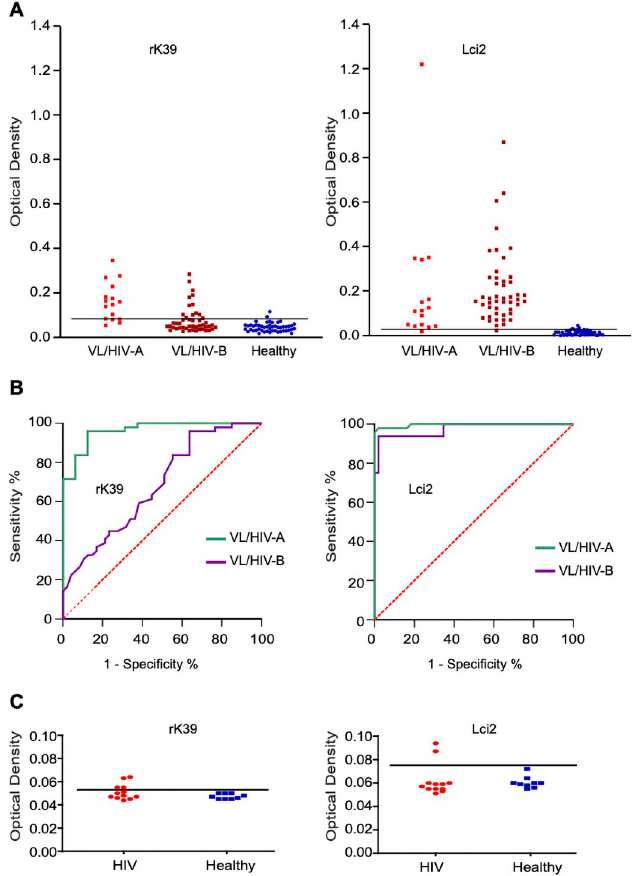
Fig 2. Serological evaluation of rK39 and Lci2 recombinant antigens with Visceral Leishmaniasis/HIV sera samples. (A) ELISA comparing the recognition of the rK39 and Lci2 recombinant proteins by human sera from VL/ HIV afflicted individuals (VL/HIV-A and VL/HIV-B). (B) Corresponding ROC curves based on the results from the ELISA assays. (C) The antigens rK39 and Lci2 were also tested with sera from patients with HIV only.